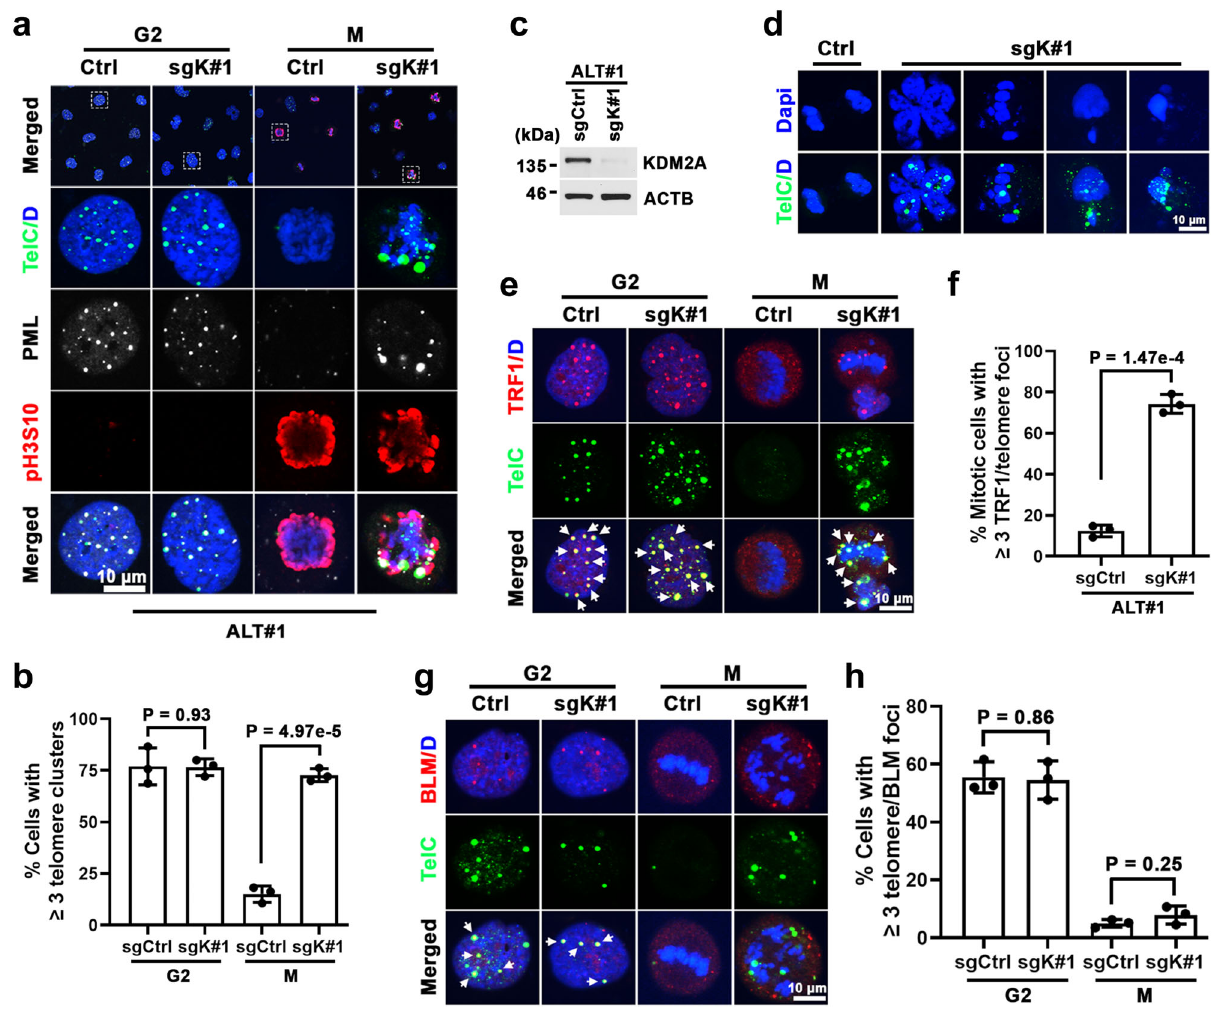
Fig. 6 | KDM2A promotes ALT telomere de-clustering after recombination. a Representative immuno-FISH images of multitelomere clusters in G2 or mitotic ALT#1 cells transduced with sgCtrl or sgK#1. The G2 cells were synchronized from sequentialthymidineandCDK1inhibitortreatment.Themitotic(M)cellswerefrom G2-synchronized cells upon 1h release from the CDK1 inhibitor. PML and mitotic marker phospho-Histone H3-Ser10 (pH3S10) were analyzed by IF and telomeres were detected by FISH. b Percentages of cells containing ≥ 3 multitelomere